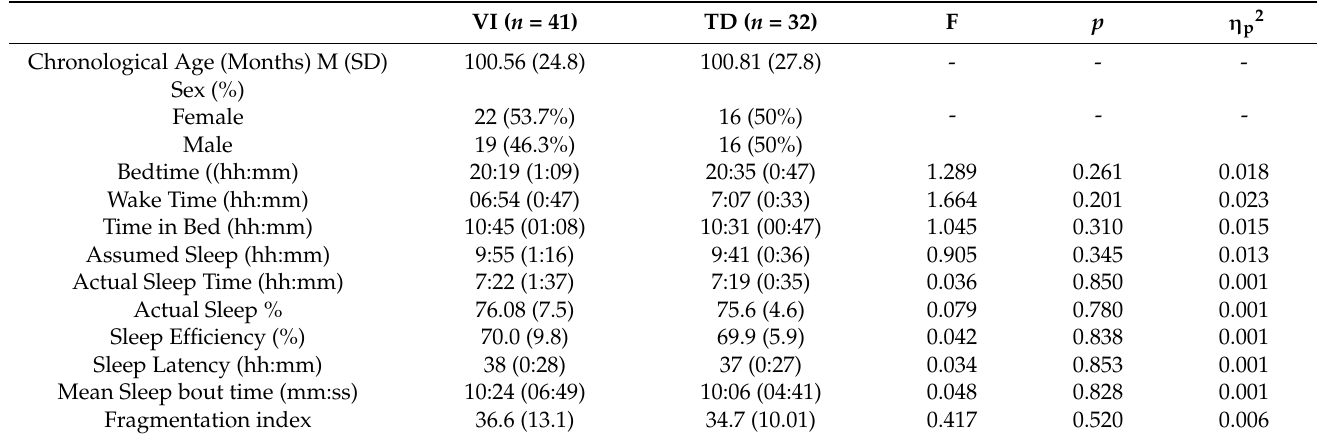
Table 4. Brief demographics mean scores (SD) and group differences using ANOVA for actigraphy variables.